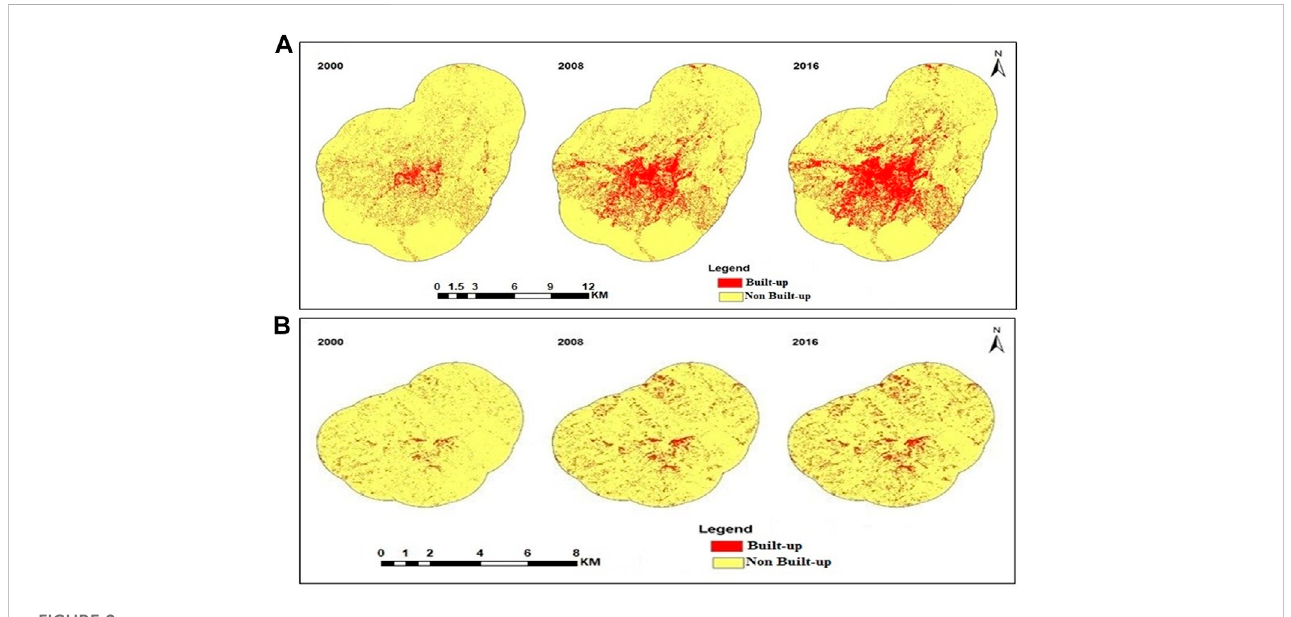
FIGURE 2 Classi fi ed map of Dehradun (A) Shimla (B) .